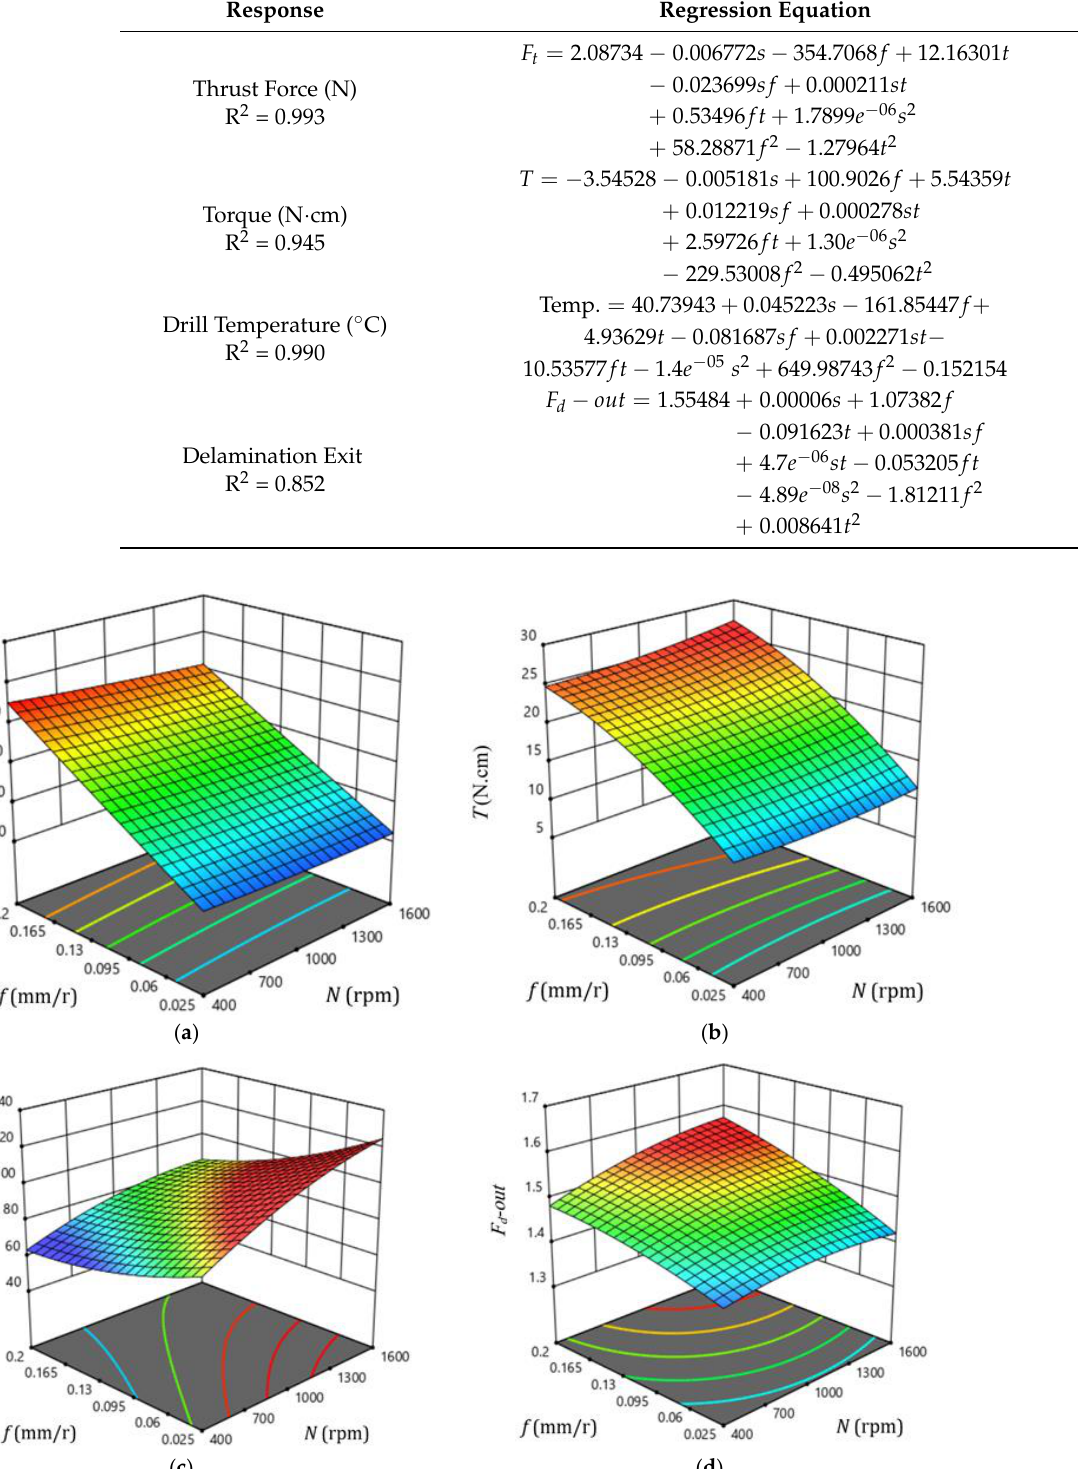
Figure 17. Contour plot of push-out delamination factor optimization at workpiece thickness of 7.7 mm. 4.2. Optimizing Delamination Factor The optimization function aims to minimize all machinability properties of drilling GFRP composites. The optimization plot in Figure 18 reveals that the optimal parameters are a feed of 0.025 mm/r, speed of 400 rpm, and material thickness of 5.3 mm, while it is observed that the optimal parameters for the minimum push-exit delamination, without respect to other machinability properties, are a feed of 0.025 mm/r, speed of 1600 rpm, and laminate thickness of 5.3 mm. This combination may produce the minimum push-exit de- lamination but is associated with the maximum temperature, as shown in the plot dedi- cated to temperature in Figure 18.